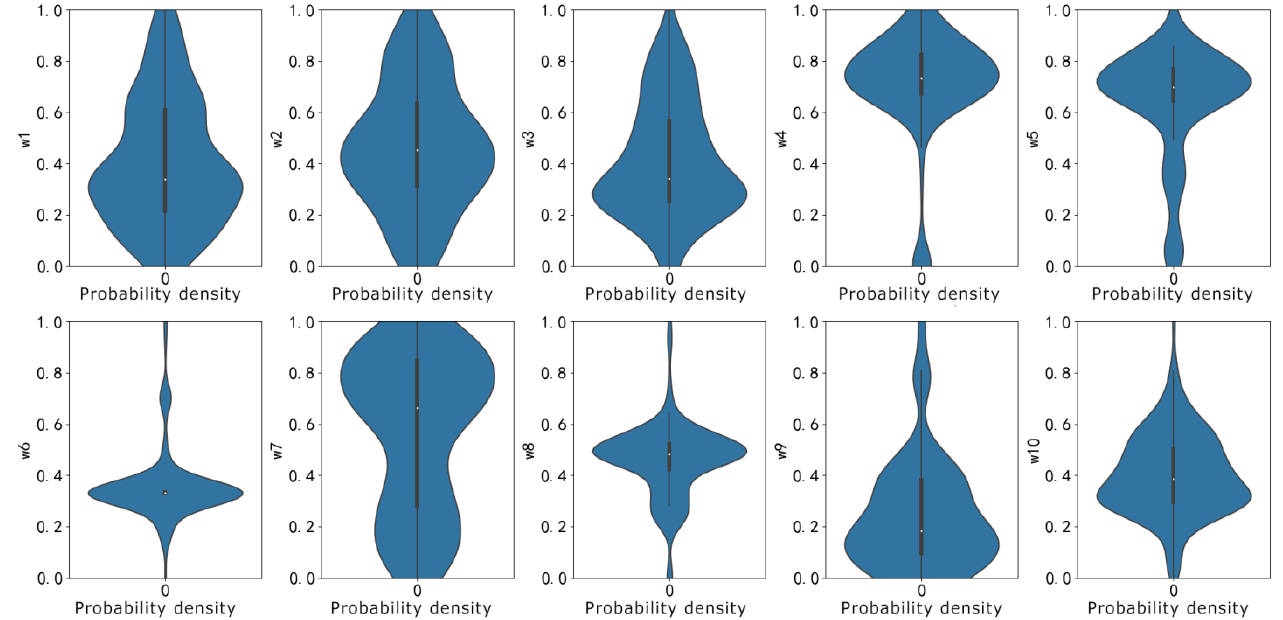
Figure 10. Probability density distribution of each weight searched by particle swarm optimization (PSO) algorithm. Table 6. Optimal weighting values searched by particle swarm search algorithm.